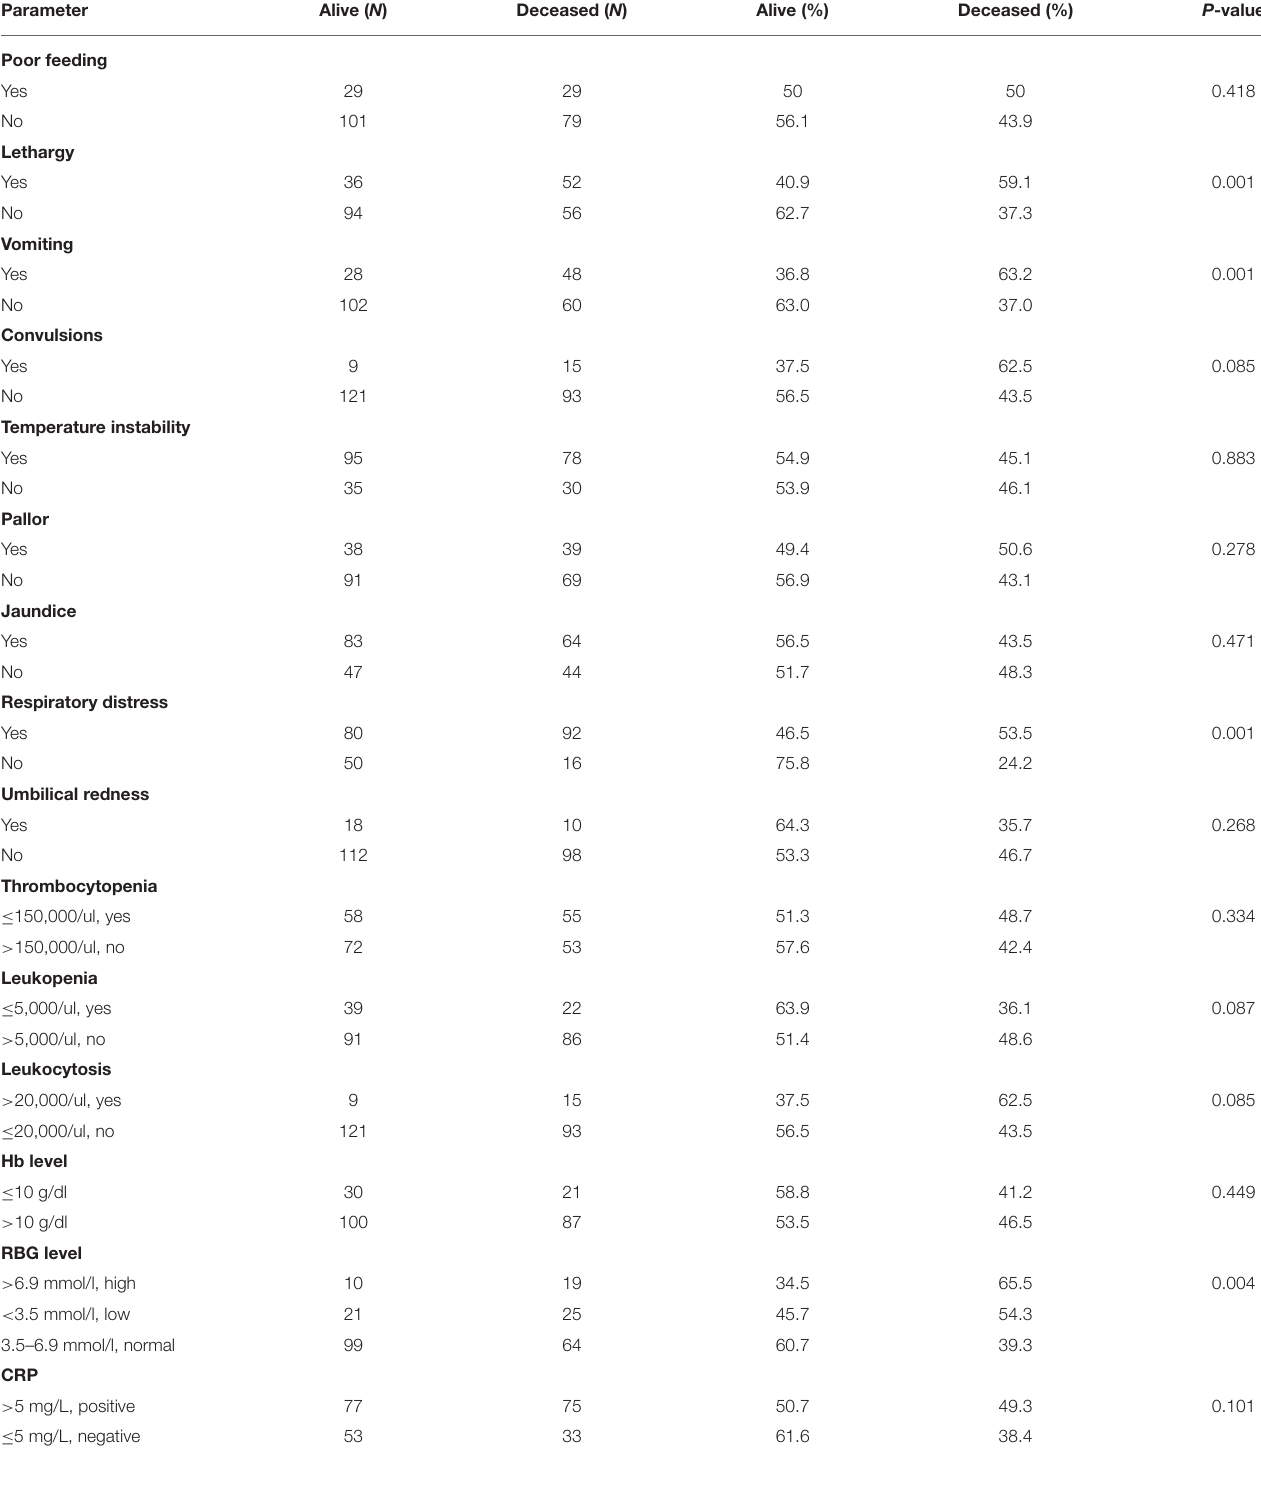
TABLE 2 | Comparison of neonates with sepsis between those who survived and those who died according to clinical features and laboratory parameters. Parameter Alive ( N ) Deceased ( N ) Alive (%) Deceased (%) P -value Poor